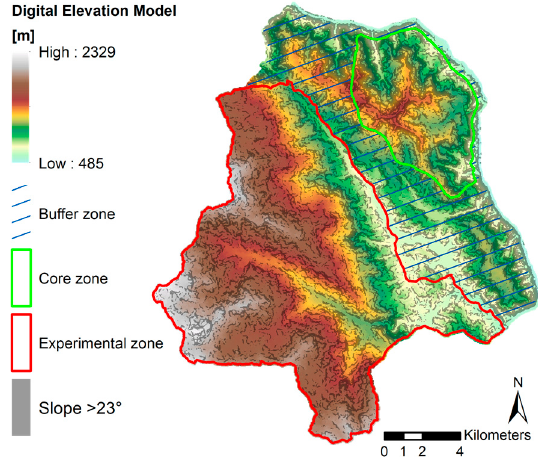
Figure 1. Map of Nabanhe Reserve featuring functional zones from the Man and Biosphere Programme and a digital elevation model in a 30 × 30 m resolution (ASTER Digital Elevation Model (“astergtm2_n22e100_dem” (ASTER GDEM is a product of METI and NASA))). Steep slopes (>23°) were derived from the ASTER DEM using the “Slope” tool of ArcGIS (Version 10.3.1) and are depicted in a grey shade.